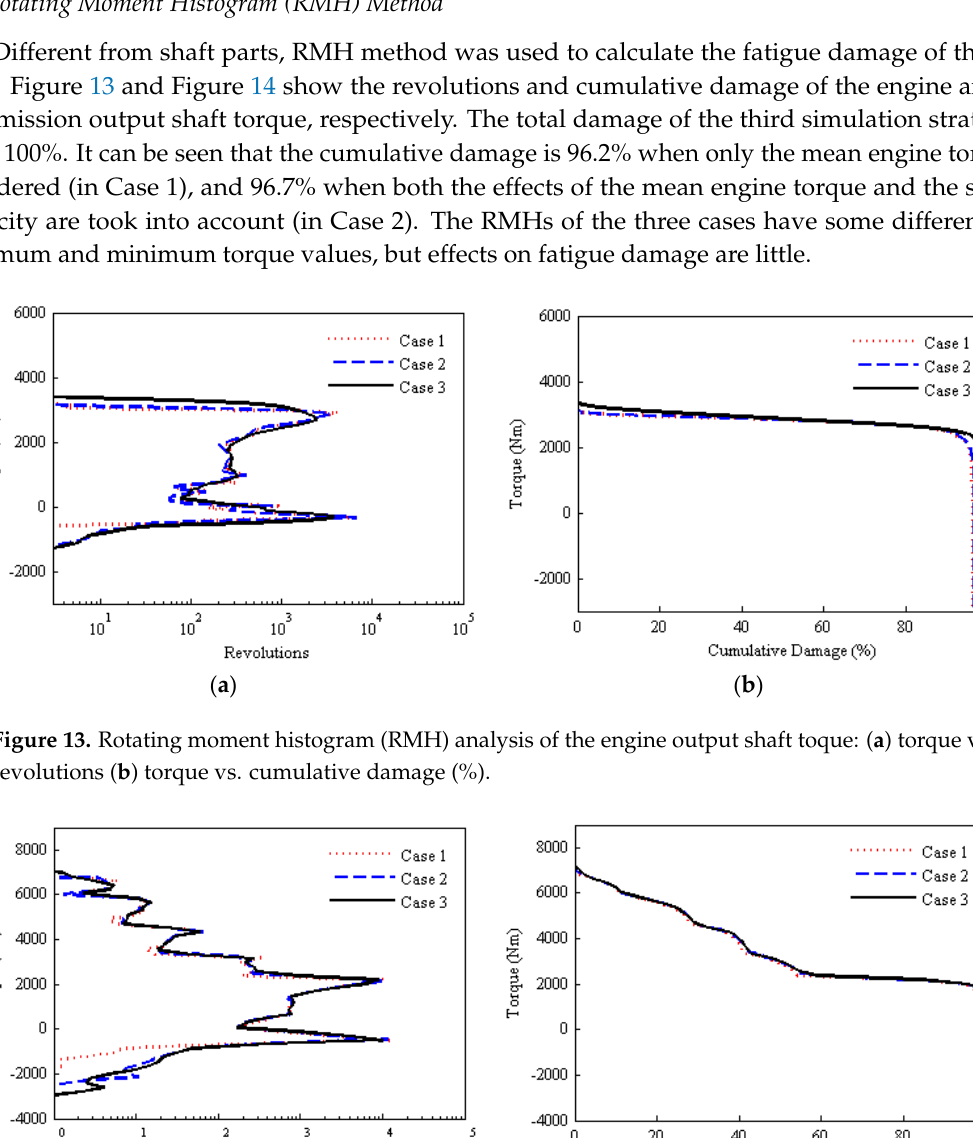
Figure 14. RMH analysis of the transmission output shaft toque: ( a ) torque vs. revolutions; ( b ) torque vs. cumulative damage (%).